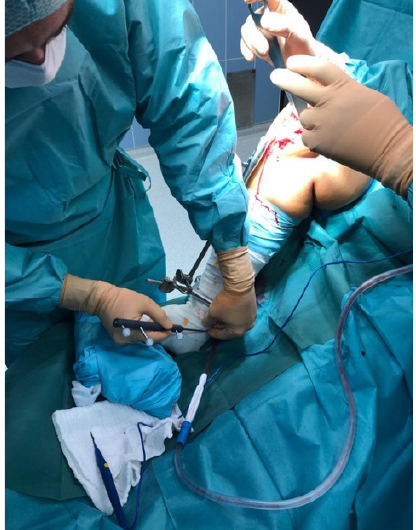
Figure 2. The surgical setup is shown. Here, the surgeon was referencing the medial malleolus. Light-reflecting spheres, attached to the pointer, were detected by an infrared camera positioned in the background.